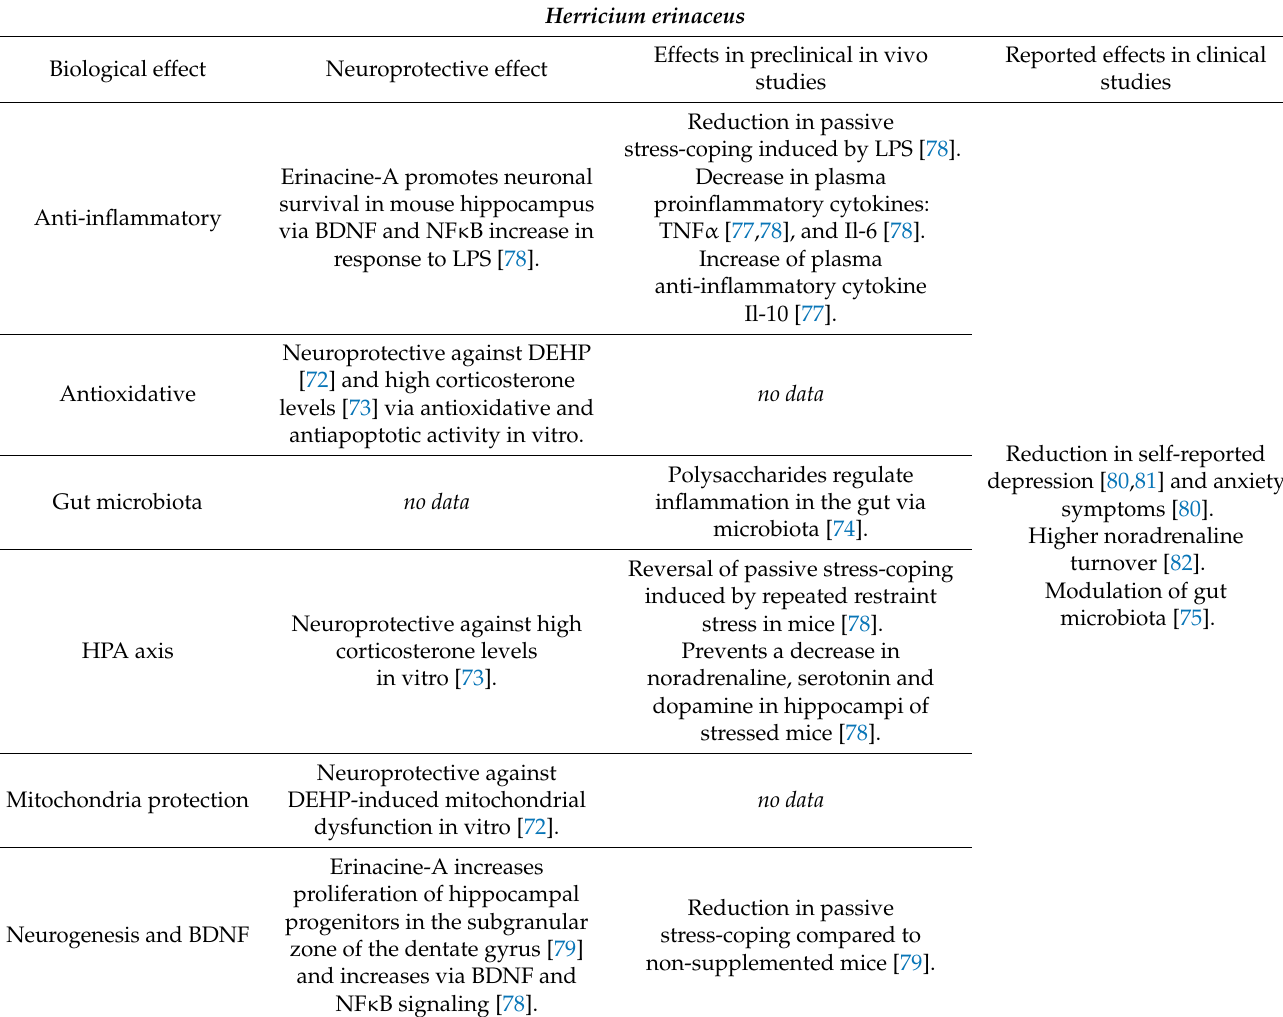
Table 3. Summary of mechanisms implicated in the impact of diet on depression symptoms with confirmed effects in preclinical rodent